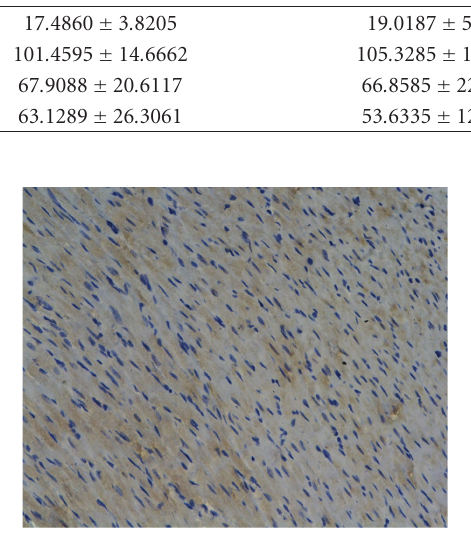
Figure 2: Model group-6h Bax × 200 (positive expression).